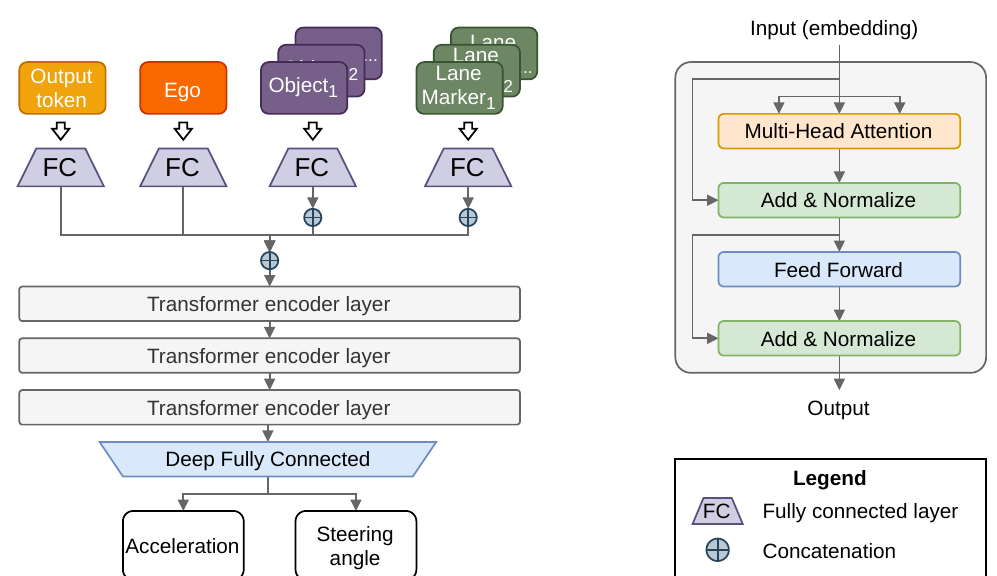
Figure 1. Architecture of the direct control network. n embd -dimensional input embeddings of a const output token, Ego features ( o ego ), objects o obj for i = 1.. n max_obj , and lane markers i R n embd × ( 1 + 1 + n obj + n lm ) and consumed by o lm for i = 1.. n max_lm are concatenated into matrix I i ∈ the transformer encoder layers. Encoders use a masking mechanism to prevent non-existing objects or lane markers from impacting the outputs. Ultimately transformer encoder layers produce the R n embd × ( 1 + 1 + n obj + n lm ) . The first column of O is then processed by a deep fully con- output O ∈ nected network to generate the control values a acc and a steer . Note that the transformer structure used for observation lacks positional encodings, as there is no need for sorting or prioritizing the environmental